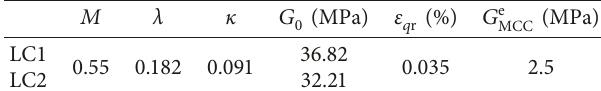
Figure 6: Variation of secant shear modulus in London Clay based on data from Jardine et al. (1984) Table 1: Parameters of Modified Cam Clay and enhanced Modified Cam Clay